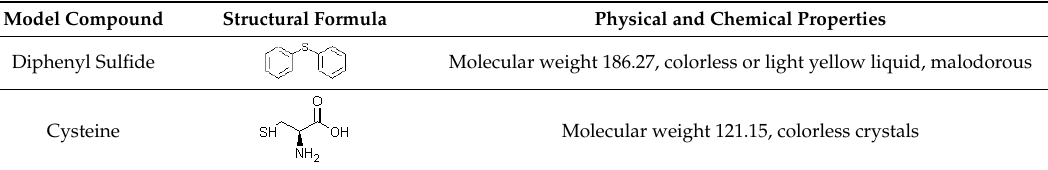
Table 4. Model organic sulfur compounds.